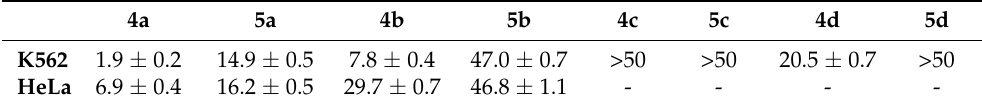
Table 3. Annexin V-FITC/Propidium iodide (PI) dual staining assay of K562 and HeLa cells treated with cycloadducts 4a and 5a at concentrations 5, 10 and 20 μ g/mL using flow cytometry.